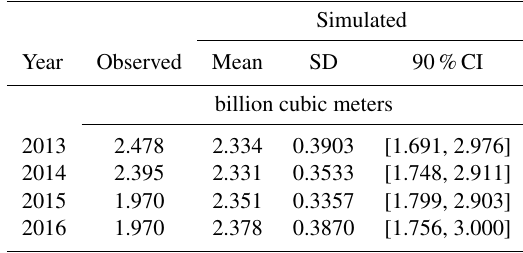
Table A3. Comparison of observed and simulated water with- drawals, GMD3 Total, 2013–2016. SD denotes standard